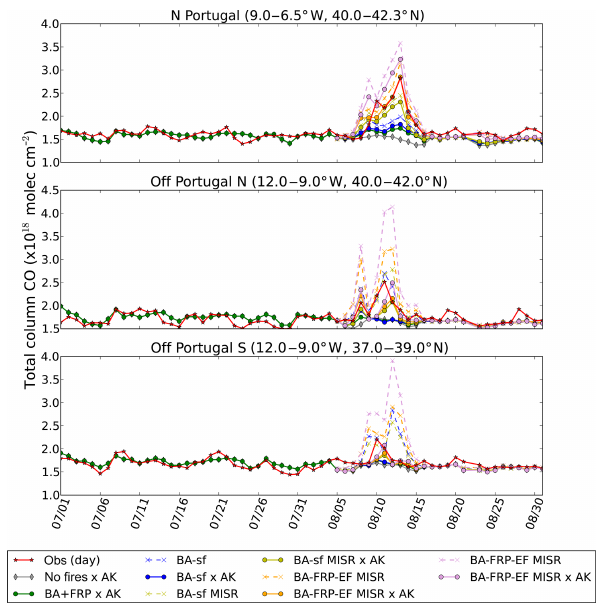
Figure 18. Daily averaged observed (IASI) and simulated (CHIMERE) CO total columns during July–August 2016 over three subregions (mapped in Fig. 9). Results from different CHIMERE simulations are plotted (described in Table 4). Simulated total CO are plotted with and without smoothing by the IASI averaging ker- nels (solid lines, reference “ × AK”, and dashed lines,